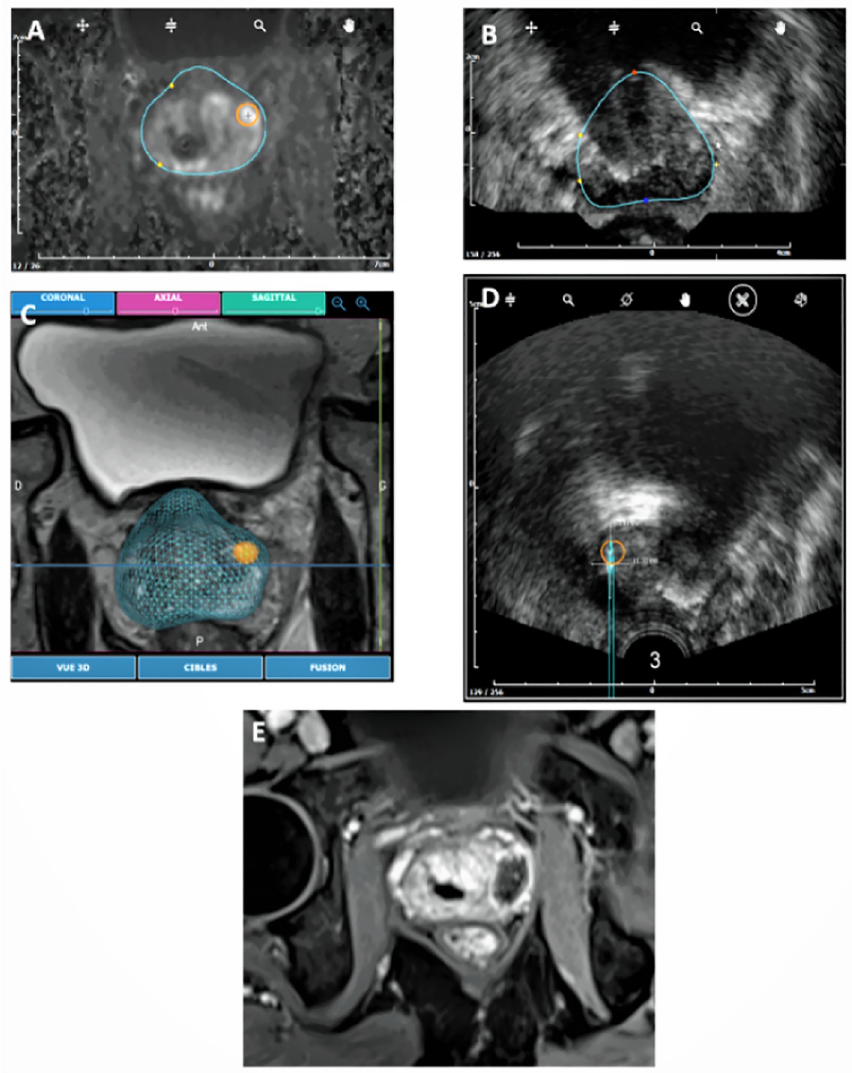
Fig 3. Elastic fusion and ablation process in patient N˚3: MRI prostate contours were delineated and the target (index tumor) was defined on the station (A). Prostate contours were then delineated on ultrasound images (B), and elastic MRI/Ultrasound fusion was performed (C). This allowed an OBT-Fusion registration of the microwave applicator and measurement on ultrasound of the expected ablation (D), based on ex-vivo predictive ablation charts. The site of ablation was then visualized 7 days after ablation on Dynamic Contrast Enhanced MRI